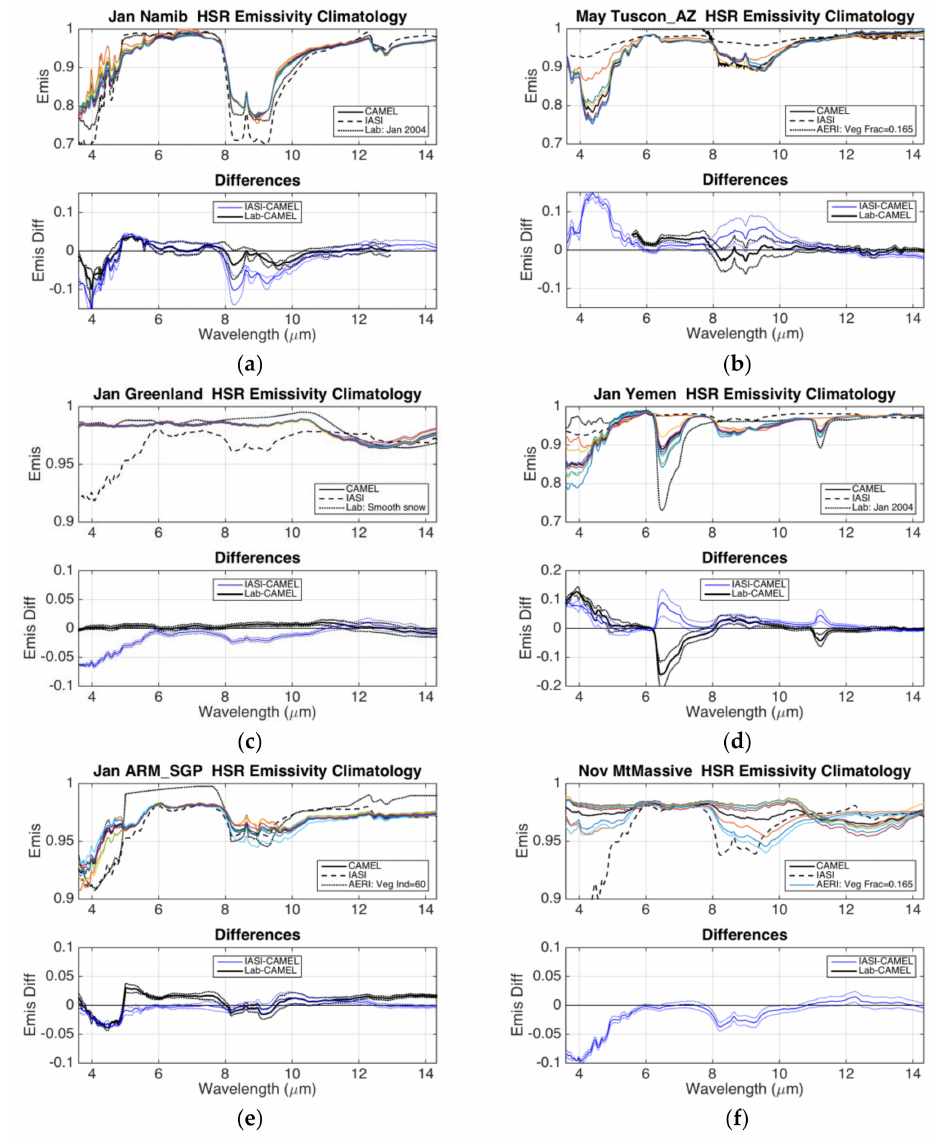
Figure 4. High spectral resolution (HSR) emissivity for ( a ) January Namib ( − 24.25N, 15.25E); ( b ) May Tucson, AZ (32.01N, − 110.77E); ( c ) January Greenland (72.57N, − 38.45E); ( d ) January Yemen (19.15N, 55.57E); ( e ) January Atmospheric Radiation Measurement, Southern Great Plains (ARM SGP) (36.60N, − 97.48E); and ( f ) Nov Mt. Massive (39.17N, − 106.47E) case sites. Top panels show CAMEL 8-year averaged (solid black), lab measurement (dotted black), and Infrared Atmospheric Sounding Interferometer (IASI) 8-year averaged (dashed black) HSR emissivity spectra overlaid on top of the individual CAMEL spectra for the years over which the aforementioned average was computed (colored). Bottom panel shows differences of the IASI minus CAMEL averages (blue solid) and lab minus CAMEL emissivity (black solid) which are both bounded by the CAMEL HSR uncertainty (dotted